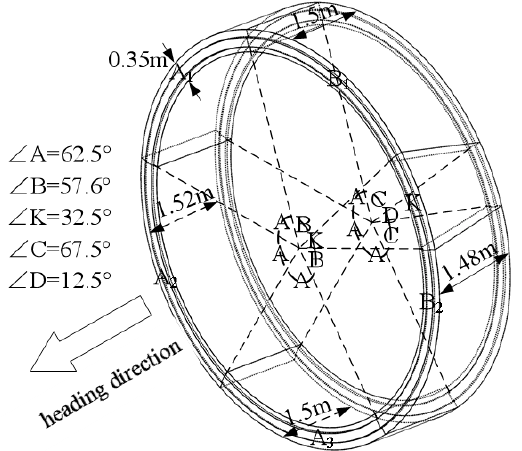
Figure 1. Segmental lining ring.